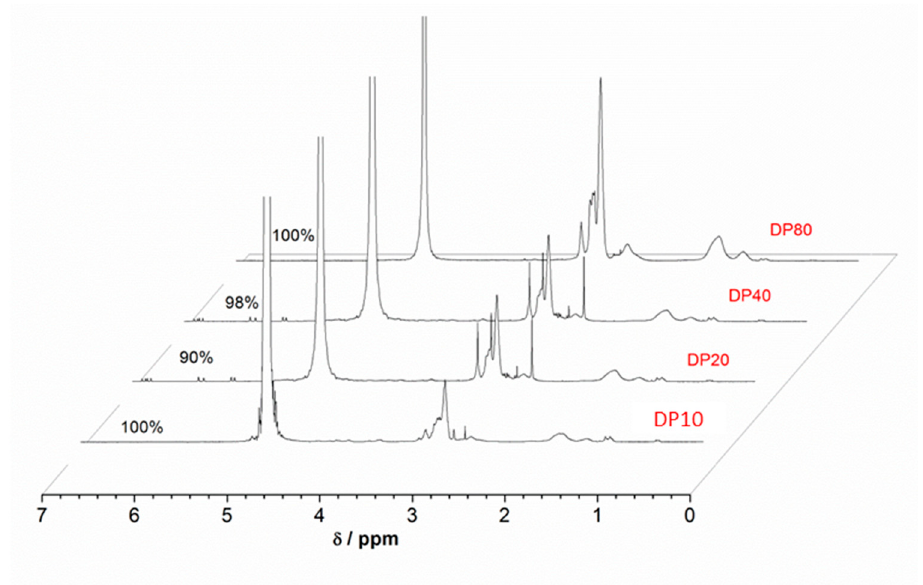
Figure 2. 1 H nuclear magnetic resonance (NMR) spectra of the Cu(0)-mediated polymerization of PDMA (DP = 10, 20, 40 and 80) in D 2 O.